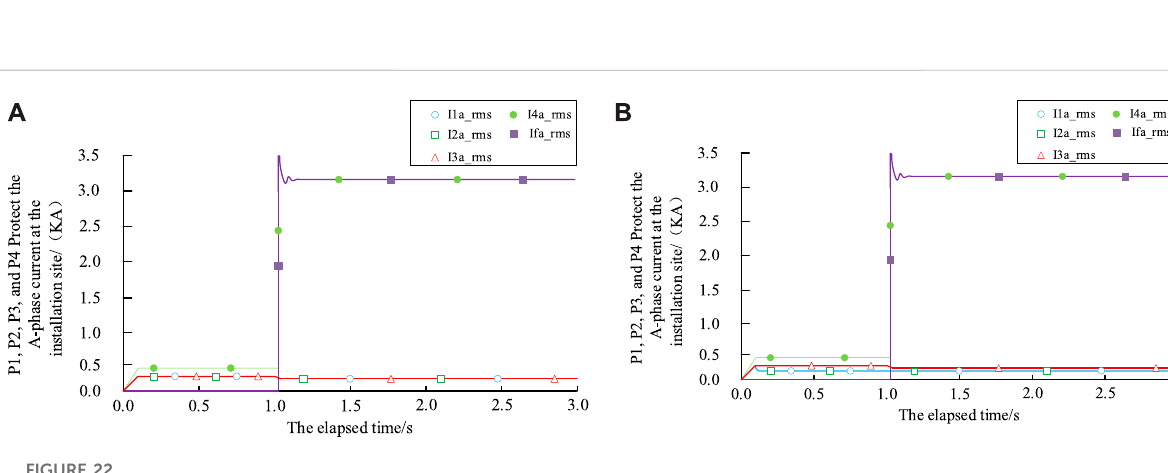
FIGURE 22 Current size at each position of AE terminal three-phase short-circuit fault. (A) Simulation results before DG access (B) simulation results after DG access.